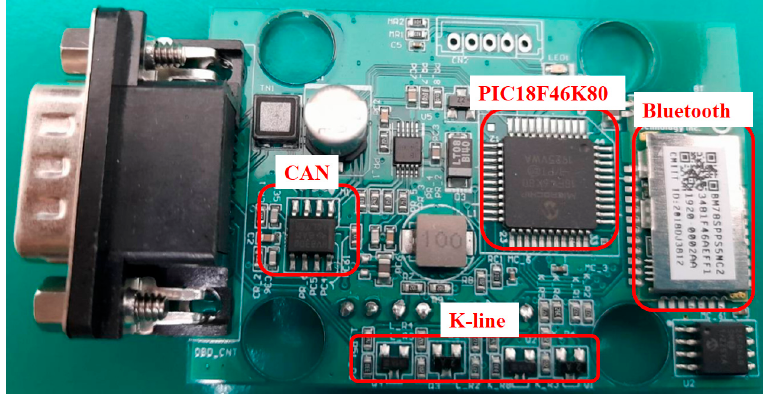
Figure 2. Hardware system.